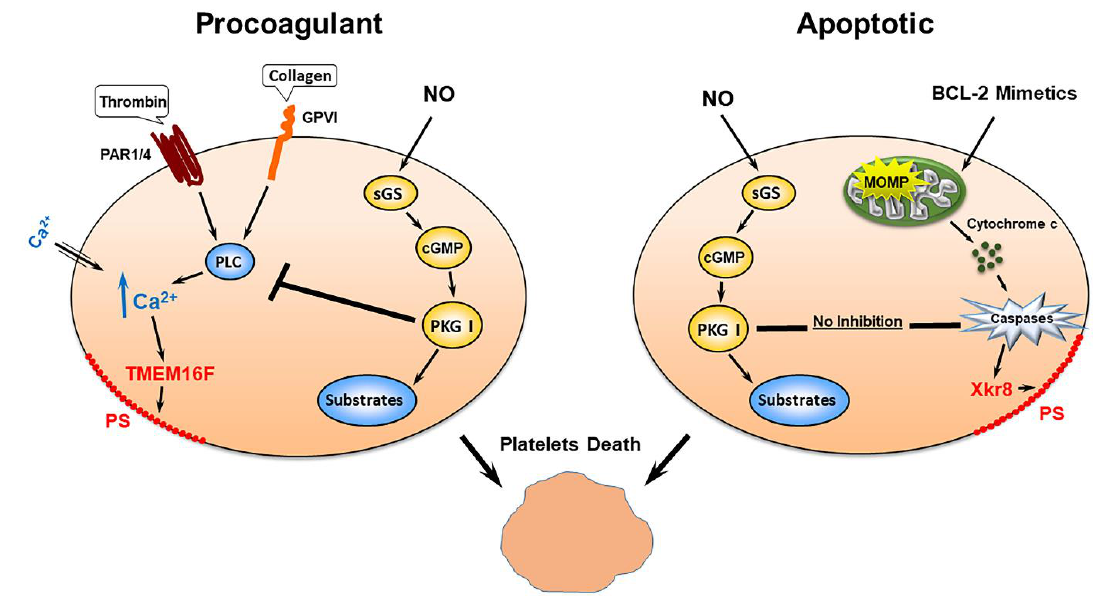
Figure 3. PKG activation inhibits pro-coagulant platelet formation but not platelet apoptosis. Both procoagulant and apoptotic platelets formation at the end lead to platelet death. Procoagulant platelets are formed by strong agonists (thrombin plus collagen) that activate respective receptors which leads to sustain increase of intracellular calcium concentration and activation of TMEM16F and PS surface externalization. Activation of PKG by endogenous NO by different mechanisms inhibited increase of intracellular calcium concentration and procoagulant platelet formation. Bcl-2 mimetics induce platelet apoptosis by activation of caspases pathways; however, in contrast to procoagulant platelets, activation of PKG does not inhibit platelet apoptosis.